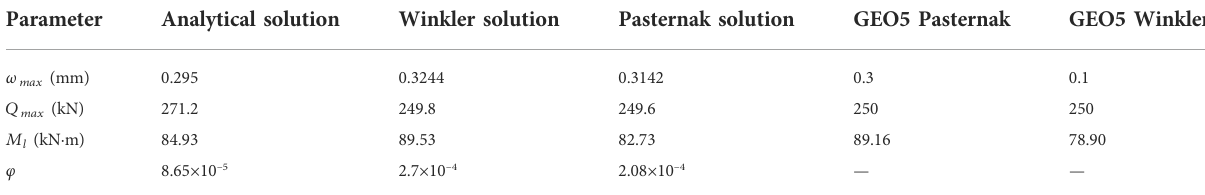
TABLE 2 Calculated results using different models.